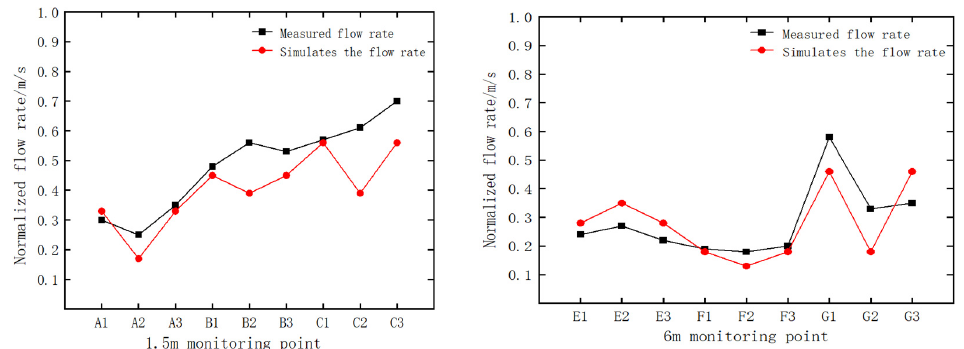
Figure 7. Line diagram of the height disparity at 1.5 m ( left ) and 6 m ( right ).